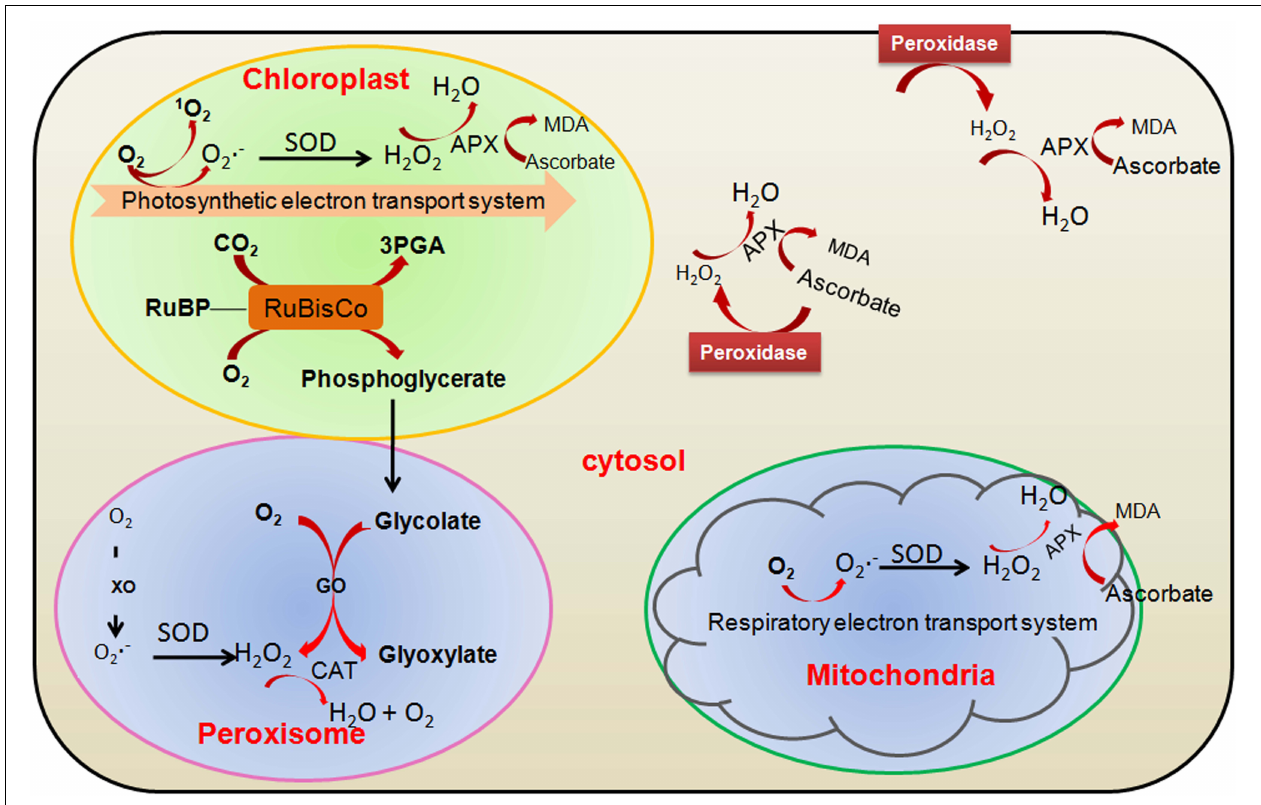
FIGURE 1 | Major sites of reactive oxygen species (ROS) production in photosynthetic cells and involvement of major antioxidative enzymes. GO, glycolate oxidase; 3PGA, 3-phosphoglycerate; RuBisCo, ribulose